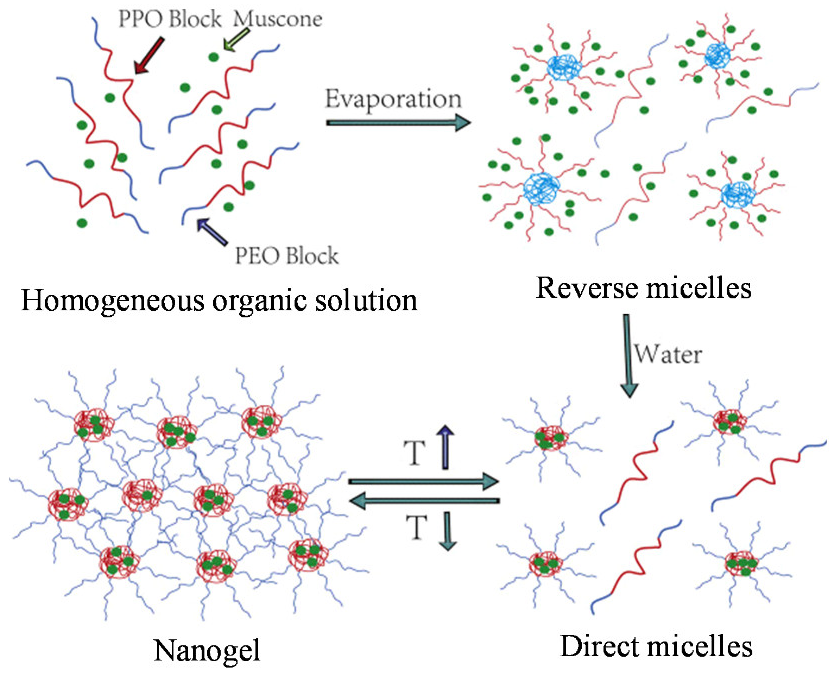
Figure 6. Design of muscone thermoresponsive nanogels prepared by RM → PM method. Reprinted from [118], Copyright 2017, with permission from Elsevier.